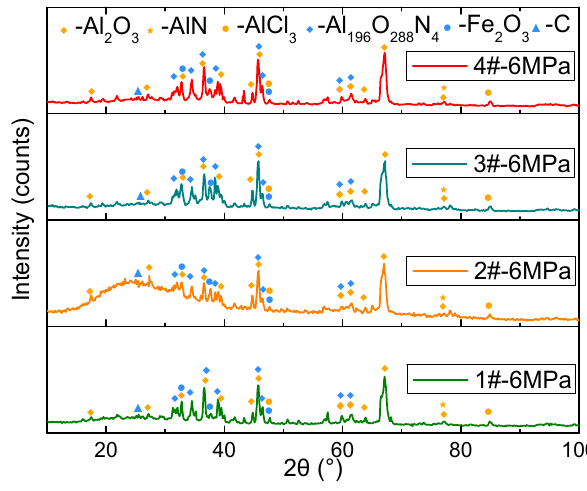
Figure 8. XRD Patterns of CCPs.